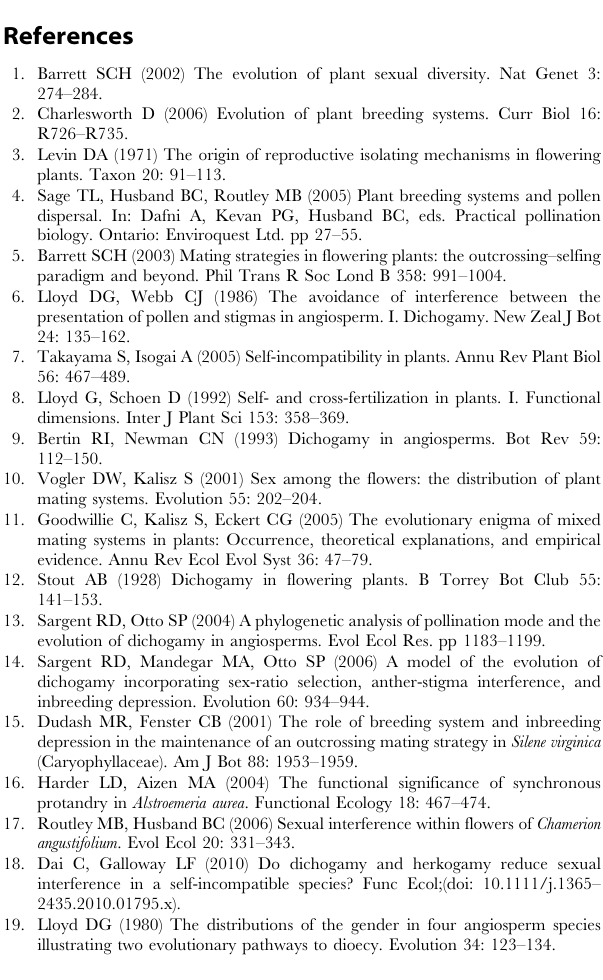
Figure S1 Frequency histograms showing the number of times that two inflorescence levels in anthesis of the same inflorescence overlapped in two populations over two years in E. boetica . Total number of censuses is shown in Table 2. (TIF)